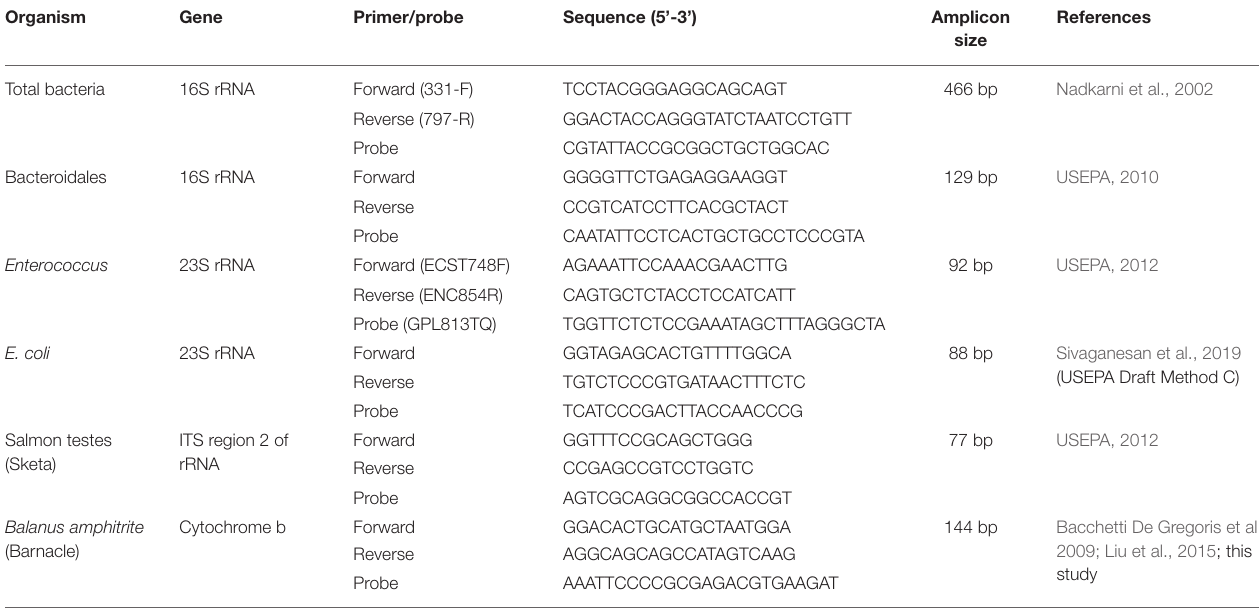
TABLE 1 | Primers and probes for qPCR